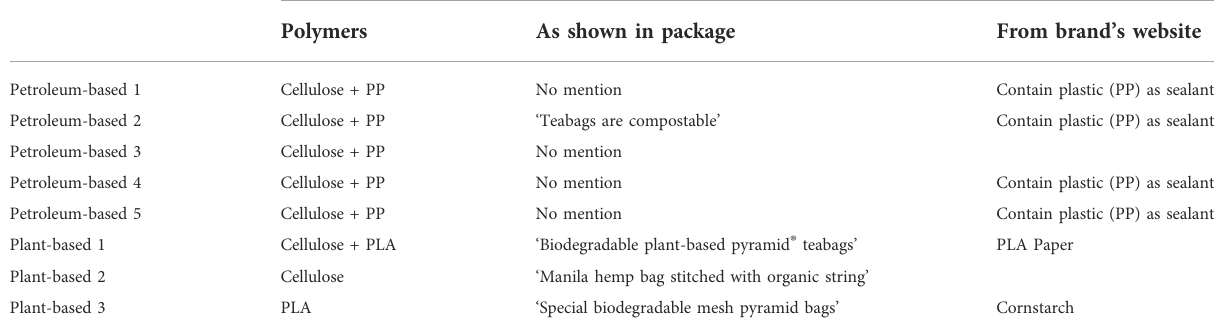
TABLE 1 Selection of teabag samples from different brands widely available in Ireland at the time of purchase (November 2020). Sample